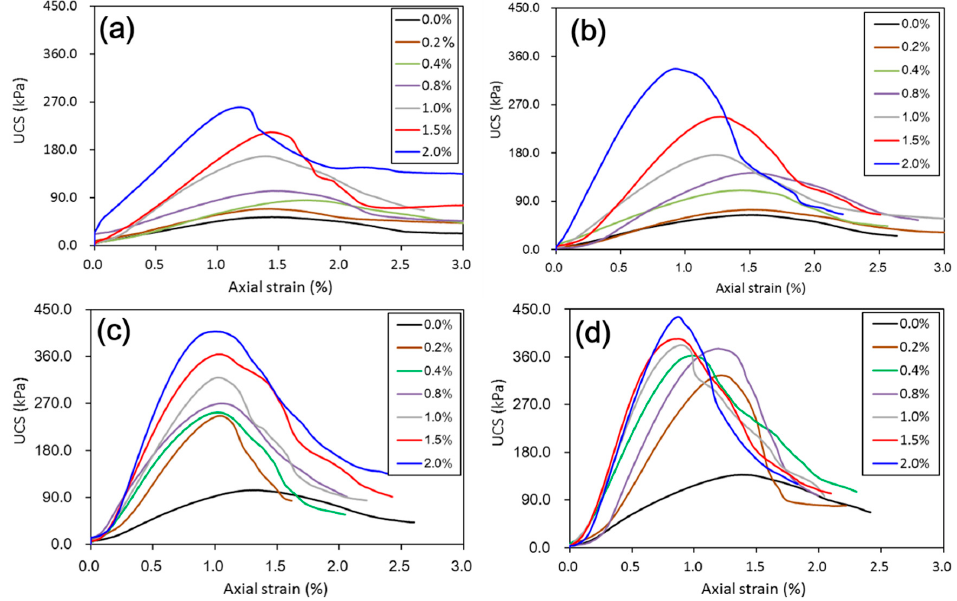
Figure 3. Effect of nano-SiO 2 content and curing duration on stress–strain curves of treated loess. ( a ) 7 days; ( b ) 14 days; ( c ) 28 days; and ( d ) 60 days. (note: 0.0% denote untreated loess).